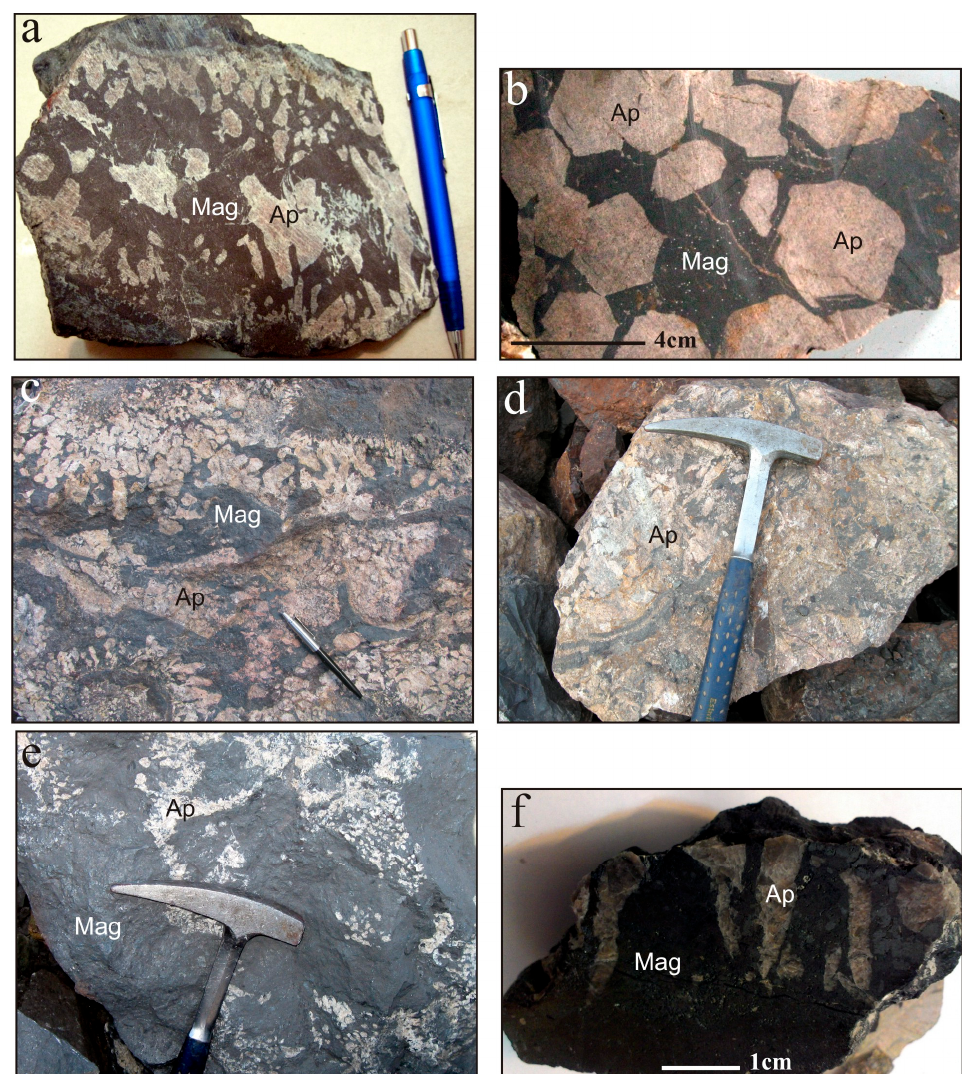
Figure 3. Photographs of representative samples from the main apatite-magnetite associations in Chadormalu. ( a , b ) Magnetite-apatite association from veins in the altered host rocks. ( c ) Apatite grains and grain aggregates in the marginal part of the main ore body. ( d ) Brecciated apatite and associated magnetite in the marginal parts of the main ore body. ( e , f ) Irregular apatite veinlets and streaks in the main ore body. Abbreviations: Ap = apatite; Mag = magnetite.